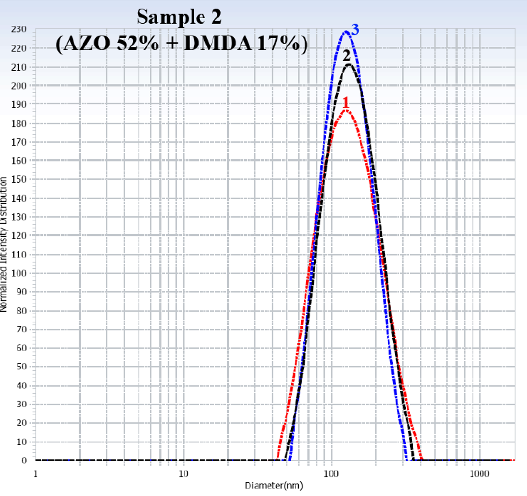
Figure 5. Micelles’ stability in time after 7 (1), 14 (2) and 21 (3) days (Sample